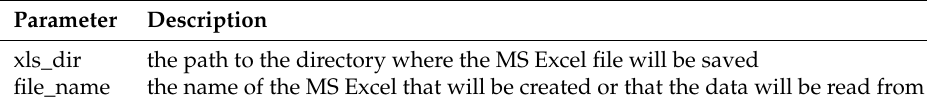
Table 4. Parameters used for creating a modified model